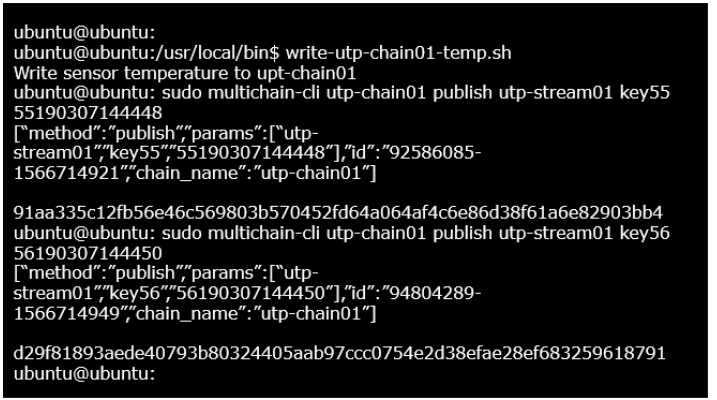
Figure 14. Transaction successfully published to IoT blockchain.